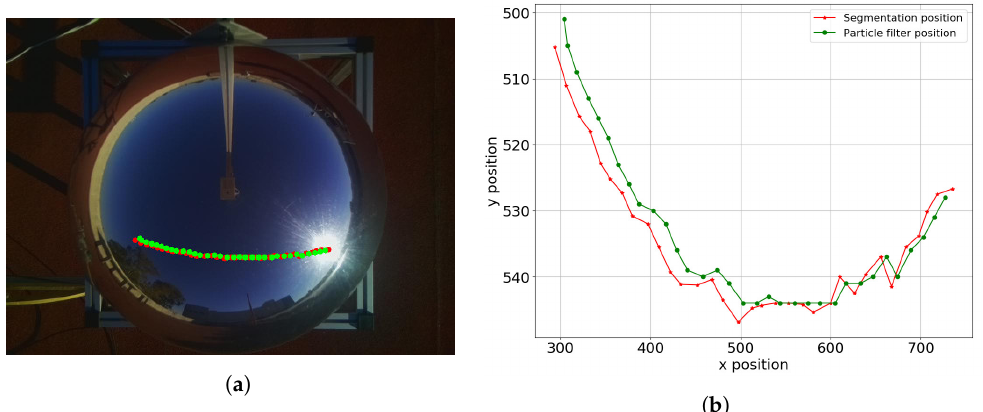
Figure 13. Path followed by the Sun. ( a ) Projection of the trajectory of the Sun. ( b ) Trajectory of the Sun.